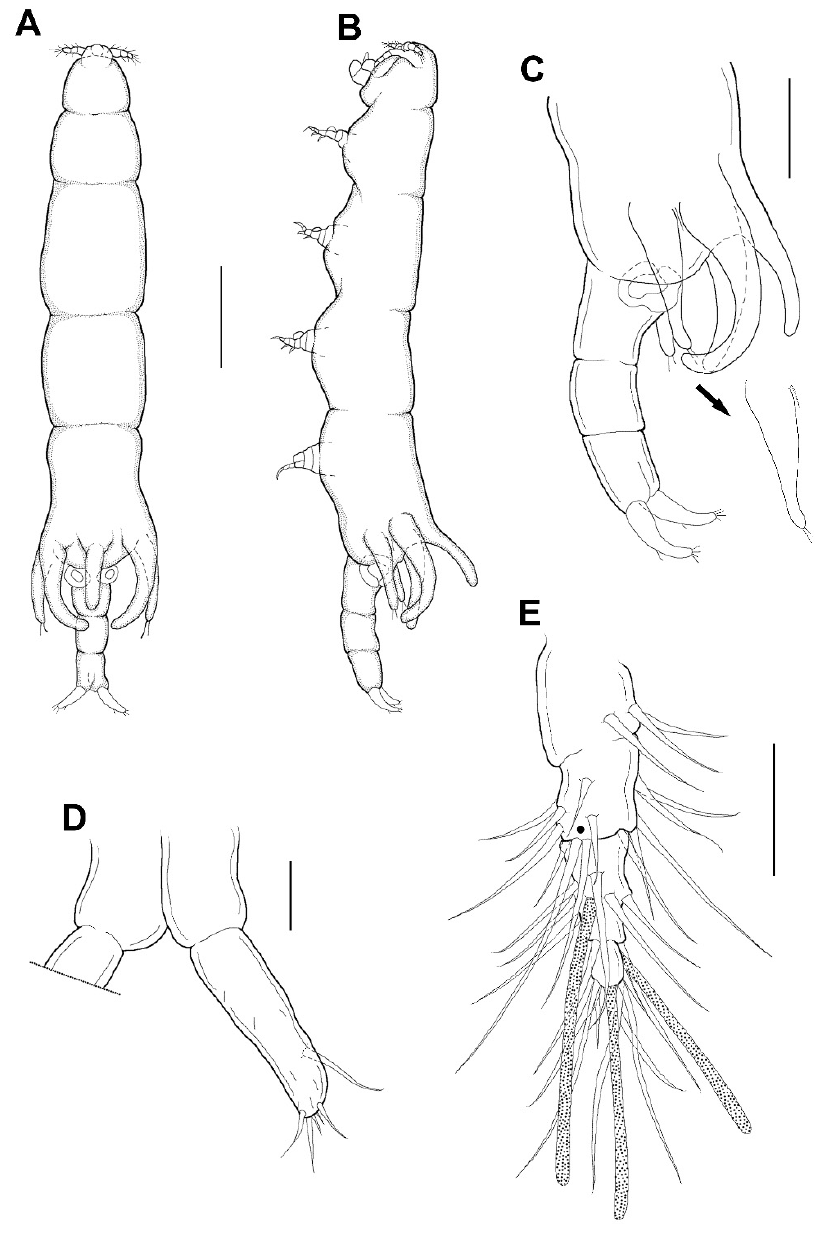
Figure 3. Xarifia yanliaoensis sp. nov. female. Habitus, dorsal ( A ); habitus, lateral ( B ); urosome, lateral; arrow indicate leg 5 ( C ); caudal ramus ( D ); antennule ( E ). Scale bars: ( A , B ) = 0.2 mm, ( C )= 0.1 mm; ( D , E ) = 0.025 mm.